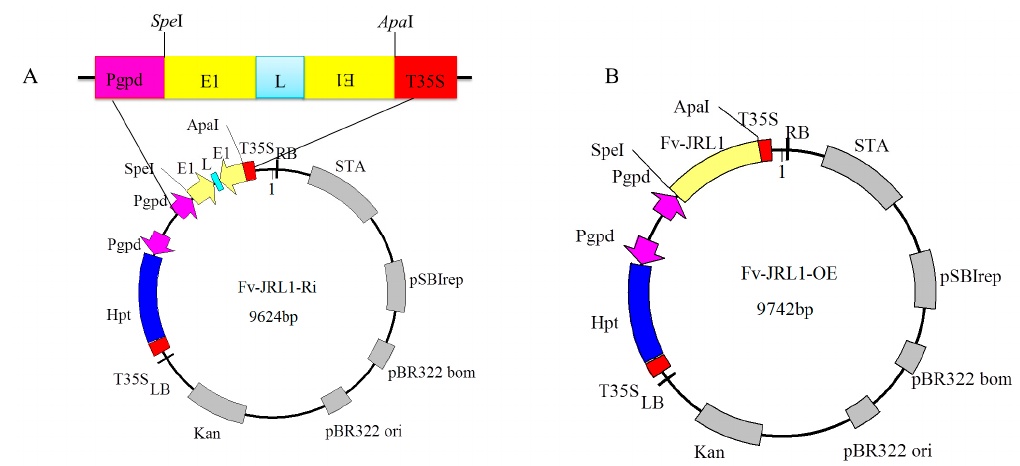
Figure 6. Binary vector Fv-JRL1-RNAi and Fv-JRL1-OE . Pgpd , A. bisporus glyceraldehyde-3-phosphate dehydrogenase gene promoter; hpt , hygromycin B phosphotransferase gene; Kan , kanamycin resistance gene; LB, left border; RB, right border. ( A ) Binary vector Fv-JRL1-RNAi ; E1, exon1; L, linker; ( B ) binary vector Fv-JRL1-OE ; Fv-JRL1, full-length of Fv-JRL1 gene from F.